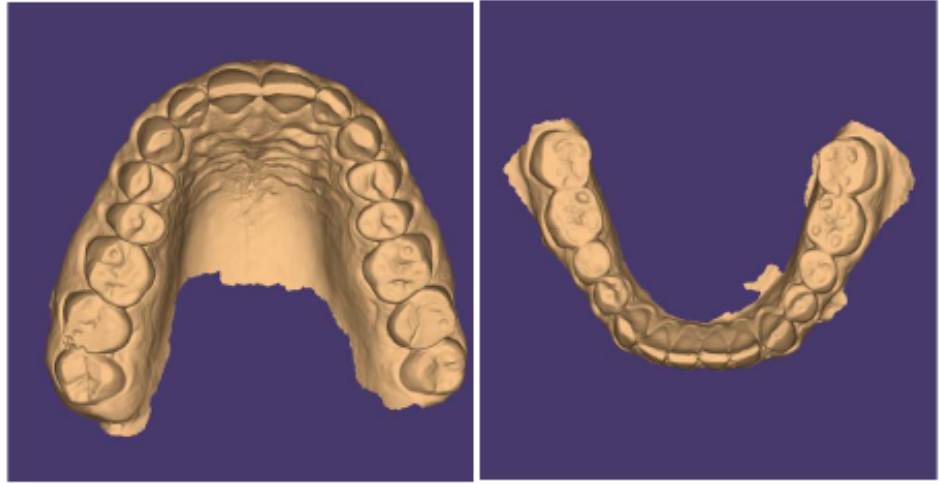
Figure 2. Occlusal view (STL files).